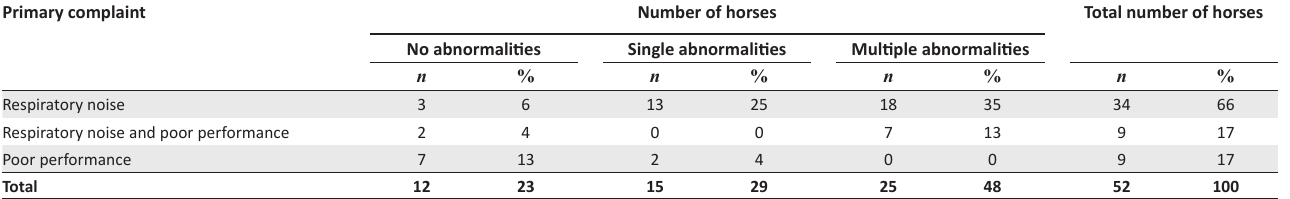
doi:10.4102/jsava.v85i1.1140http://www.jsava.co.za